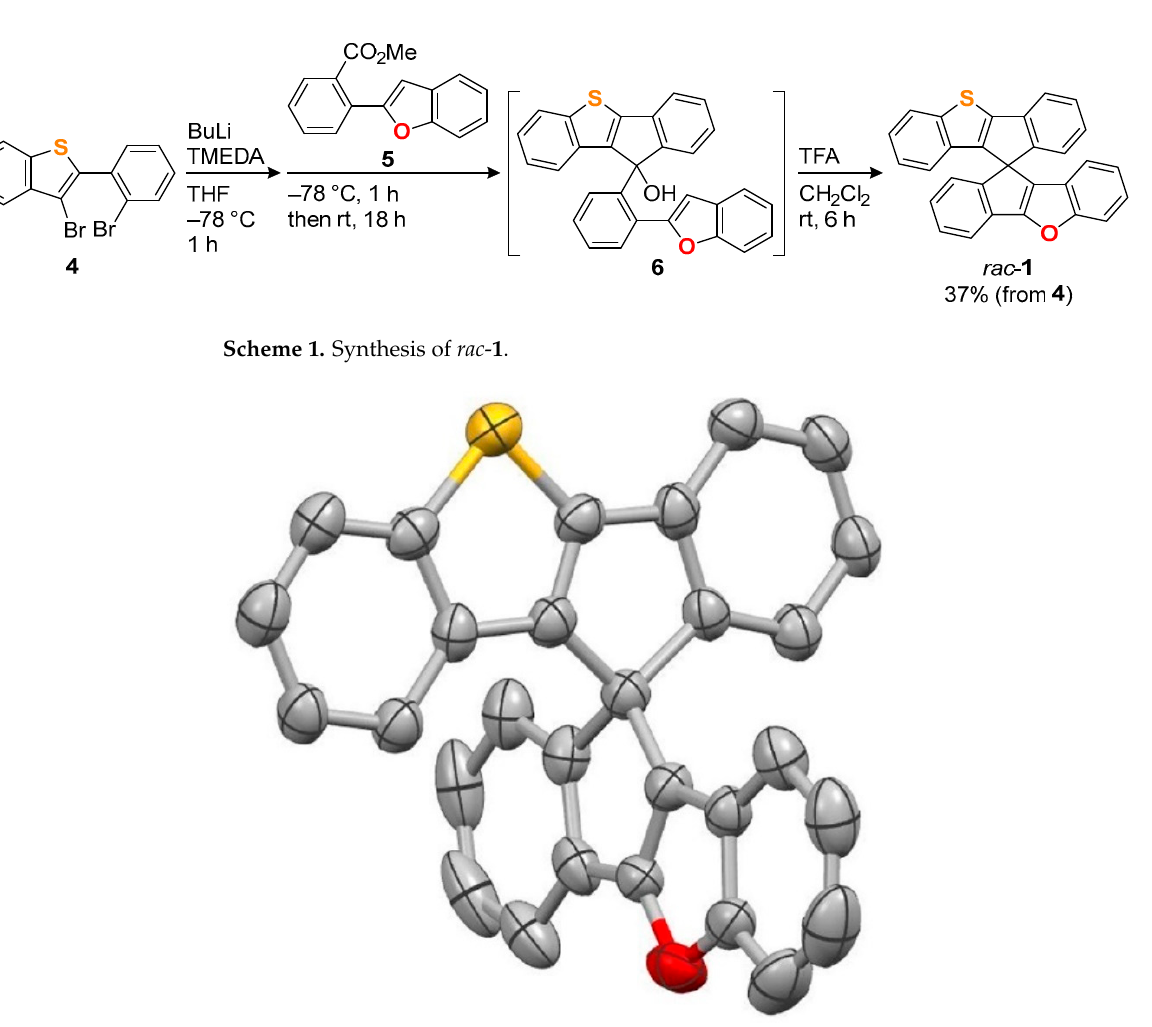
Figure 2. ORTEP drawing of rac - 1 with thermal ellipsoids at 50% probability. All hydrogen atoms are omitted for clarity.